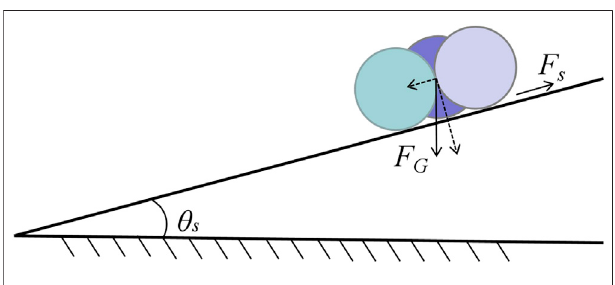
FIGURE 4 | Balance of force in static friction test.